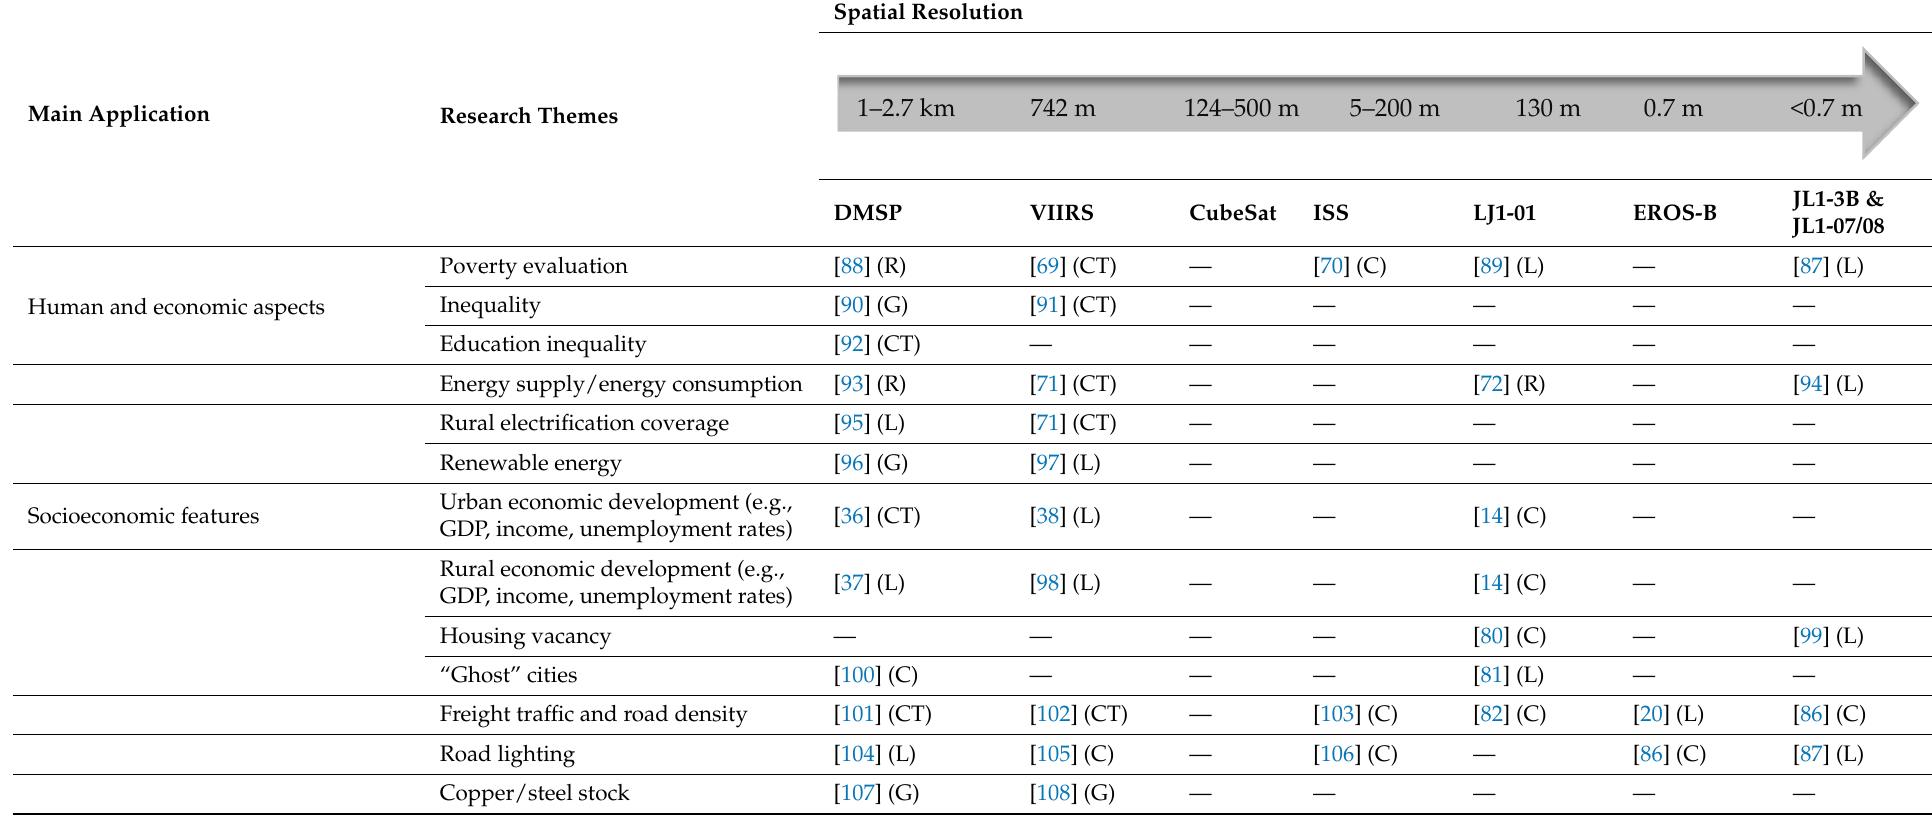
Table 3. Applications of night-time satellites by spatial resolution and location. G—Global; R—Regional, CT—Country; C—City; L—Local.